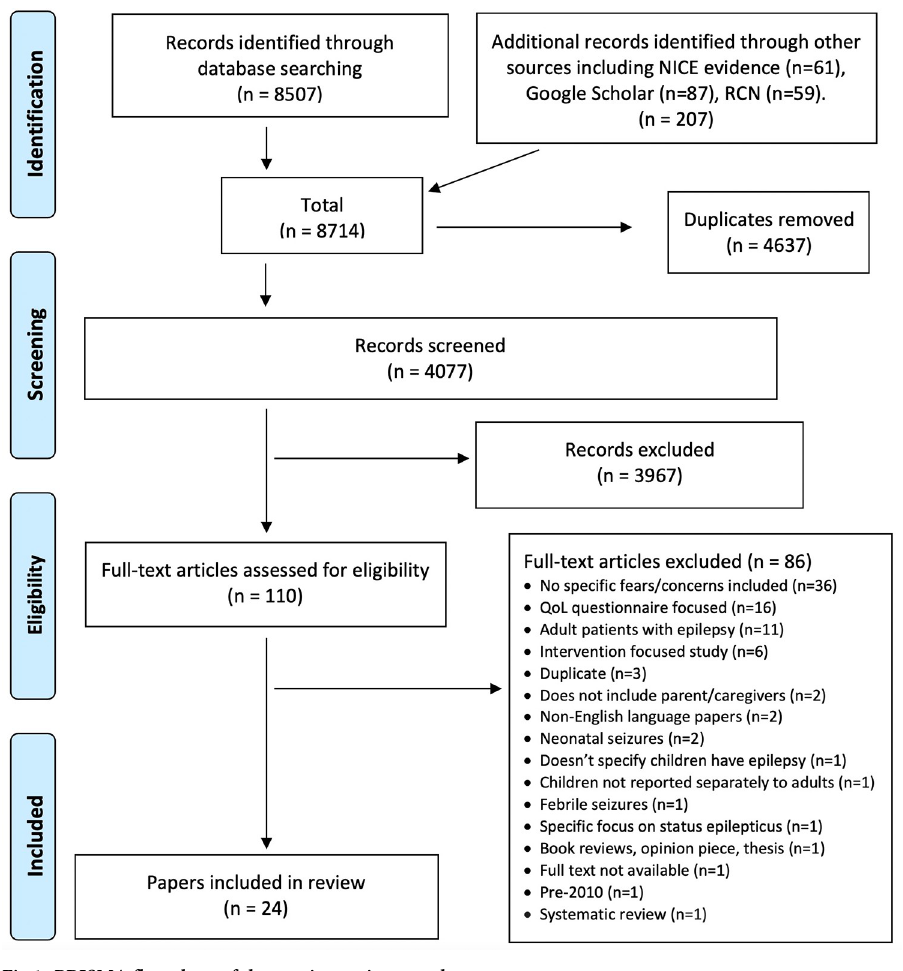
Fig 1. PRISMA flow chart of the scoping review